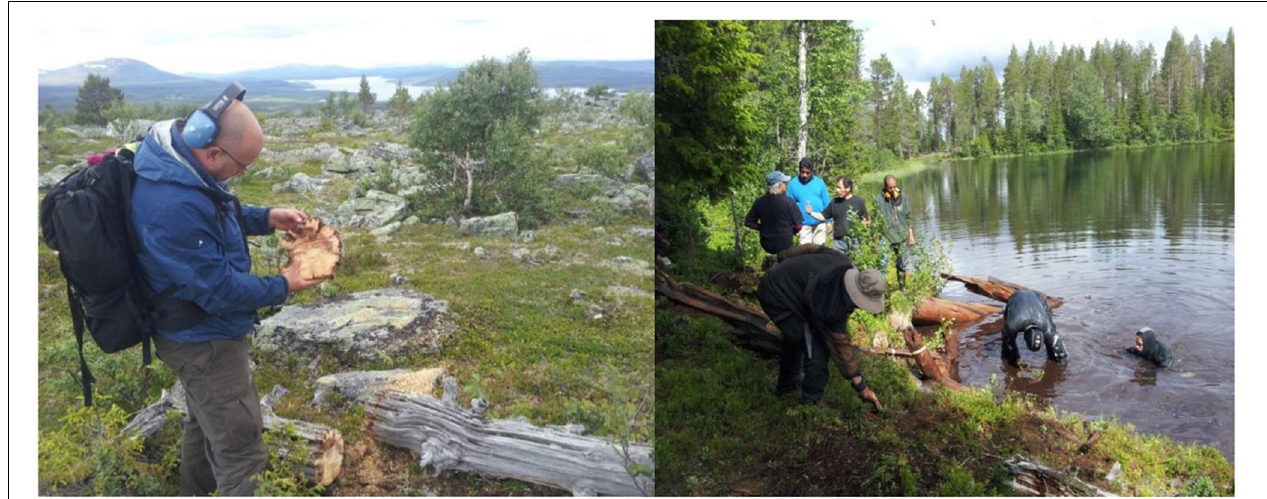
FIGURE 2 | Sampling of drywood at Håckervalen (left) and of subfossil wood at Trolltjärnen